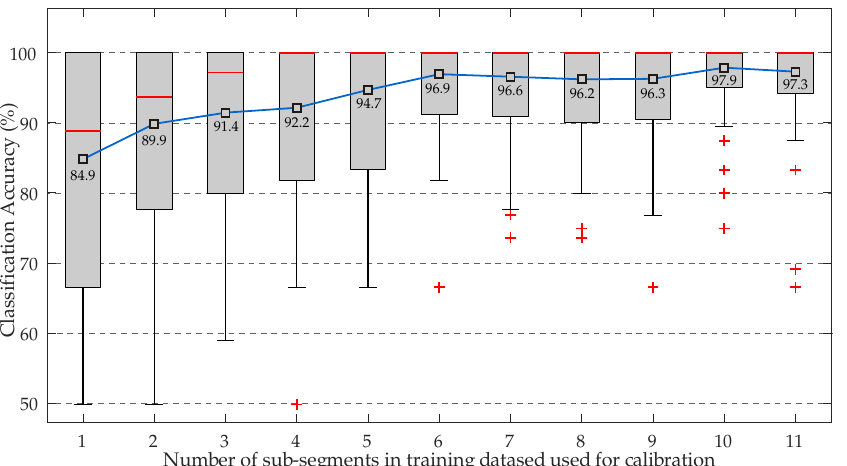
Figure 4. Classification performance provided by the KNN classifier in the discrimination between NTS and HTS individuals. Results obtained for sequential validation of consecutive sub-segments for each of the selected subject segments. In each box, the red line indicates the median, and the bottom and top edges indicate the 15th and 85th percentiles, respectively. The whiskers cover the most extreme data points not considered outliers, and the red symbol (+) stands for outliers. Black squares inside each box indicate mean